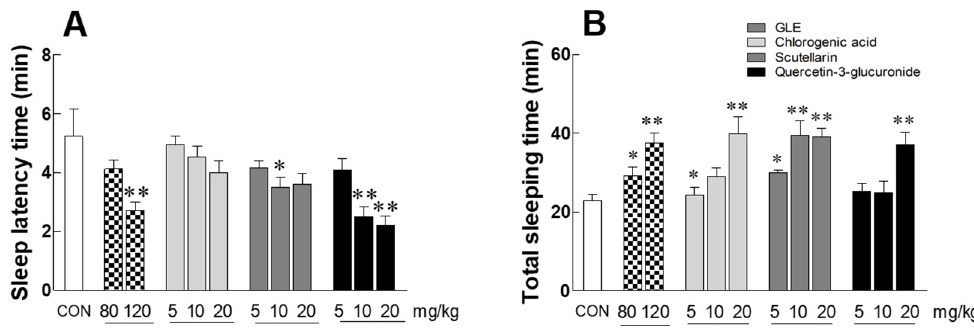
Figure 7. Effects of GLE (green lettuce leaf extract), chlorogenic acid, scutellarin, and quercetin-3-glucuronide (Q3G) on ( A ) sleep latency time and ( B ) total sleep time in mice that received a hypnotic dose of pentobarbital (42 mg/kg, i.p.). Experimental groups include the control group (CON), GLE (green lettuce leaf extract)-treated groups (80 and 120 mg/kg), chlorogenic acid, scutellarin, and Q3G-treated groups (5, 10, and 20 mg/kg). Values are presented as the mean ± standard error of the mean (SEM) for each group, n = 7. * p < 0.05 and ** p < 0.01 when compared with the CON group (ANOVA followed by post-hoc Tukey’s test).